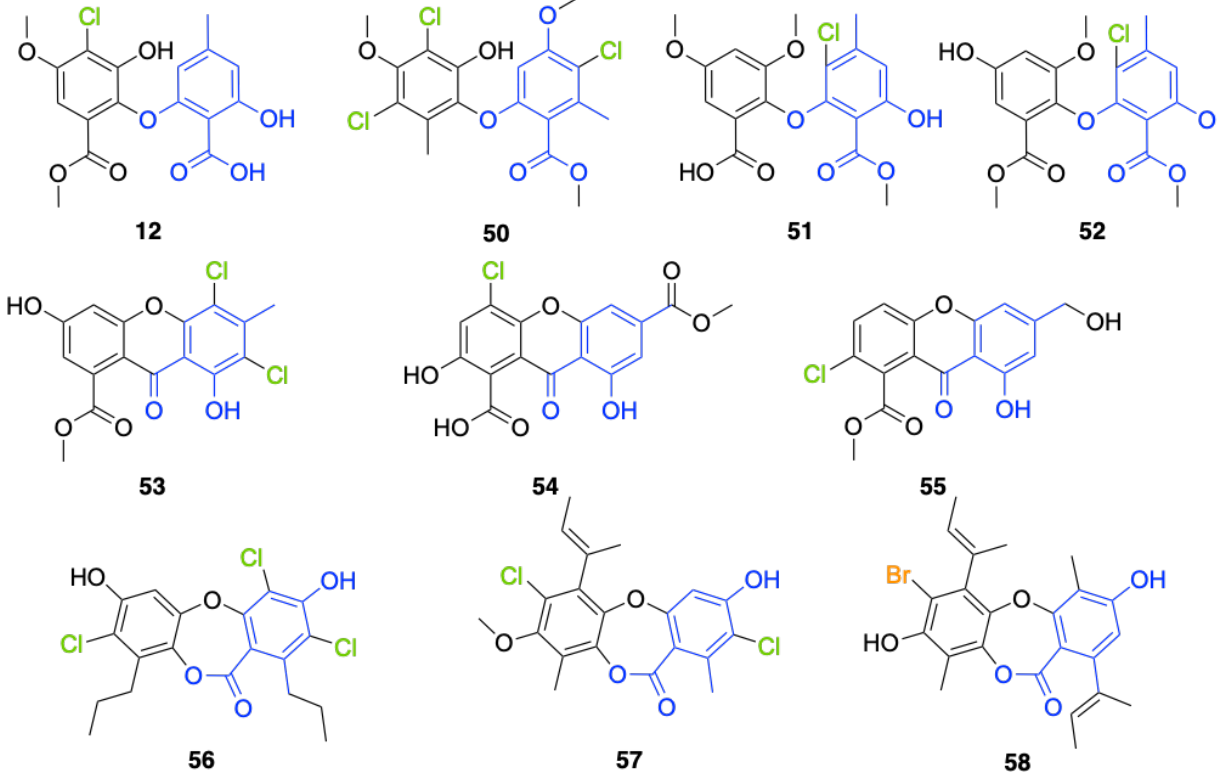
Figure 26. Pestheic acid ( 12 ) is included in cluster 2 containing buellin ( 50 ) from Diploicia sp.; chrysine D ( 51 ), penicillither ( 52 ), and penicillixanthone ( 53 ) from Penicillium sp.; 4-chlorocurvularinic acid ( 54 ) from Curvularia sp.; engyodontiumone B ( 55 ) from Engyodontium sp.; spiromastixone N ( 56 ) from Spiromastix sp.; aspersidone ( 57 ) from Aspergillus sp.; and 7-bromofolipastatin ( 58 ) from Aspergillus sp.